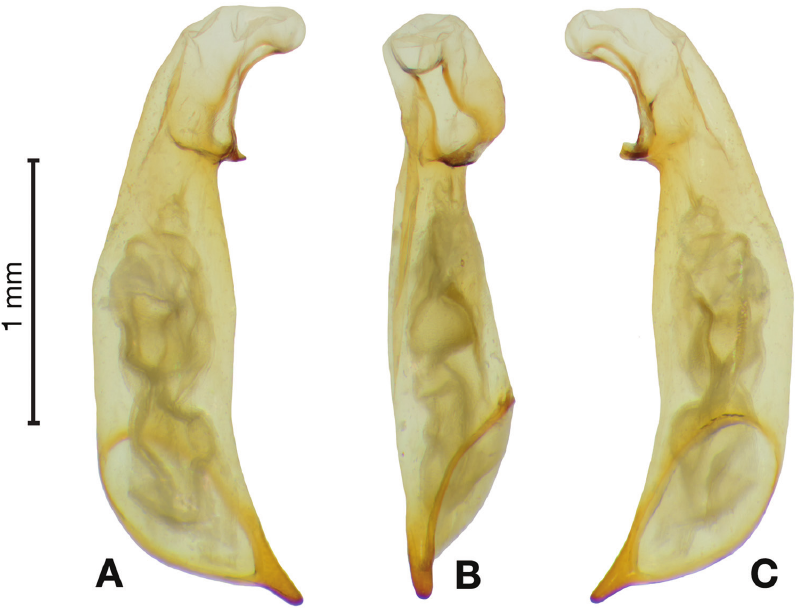
Figure 25. Digital images of male genitalia of Catascopus ( s. str. ) ignicinctus Bates, teneral. A right lateral aspect B ventral aspect C left lateral